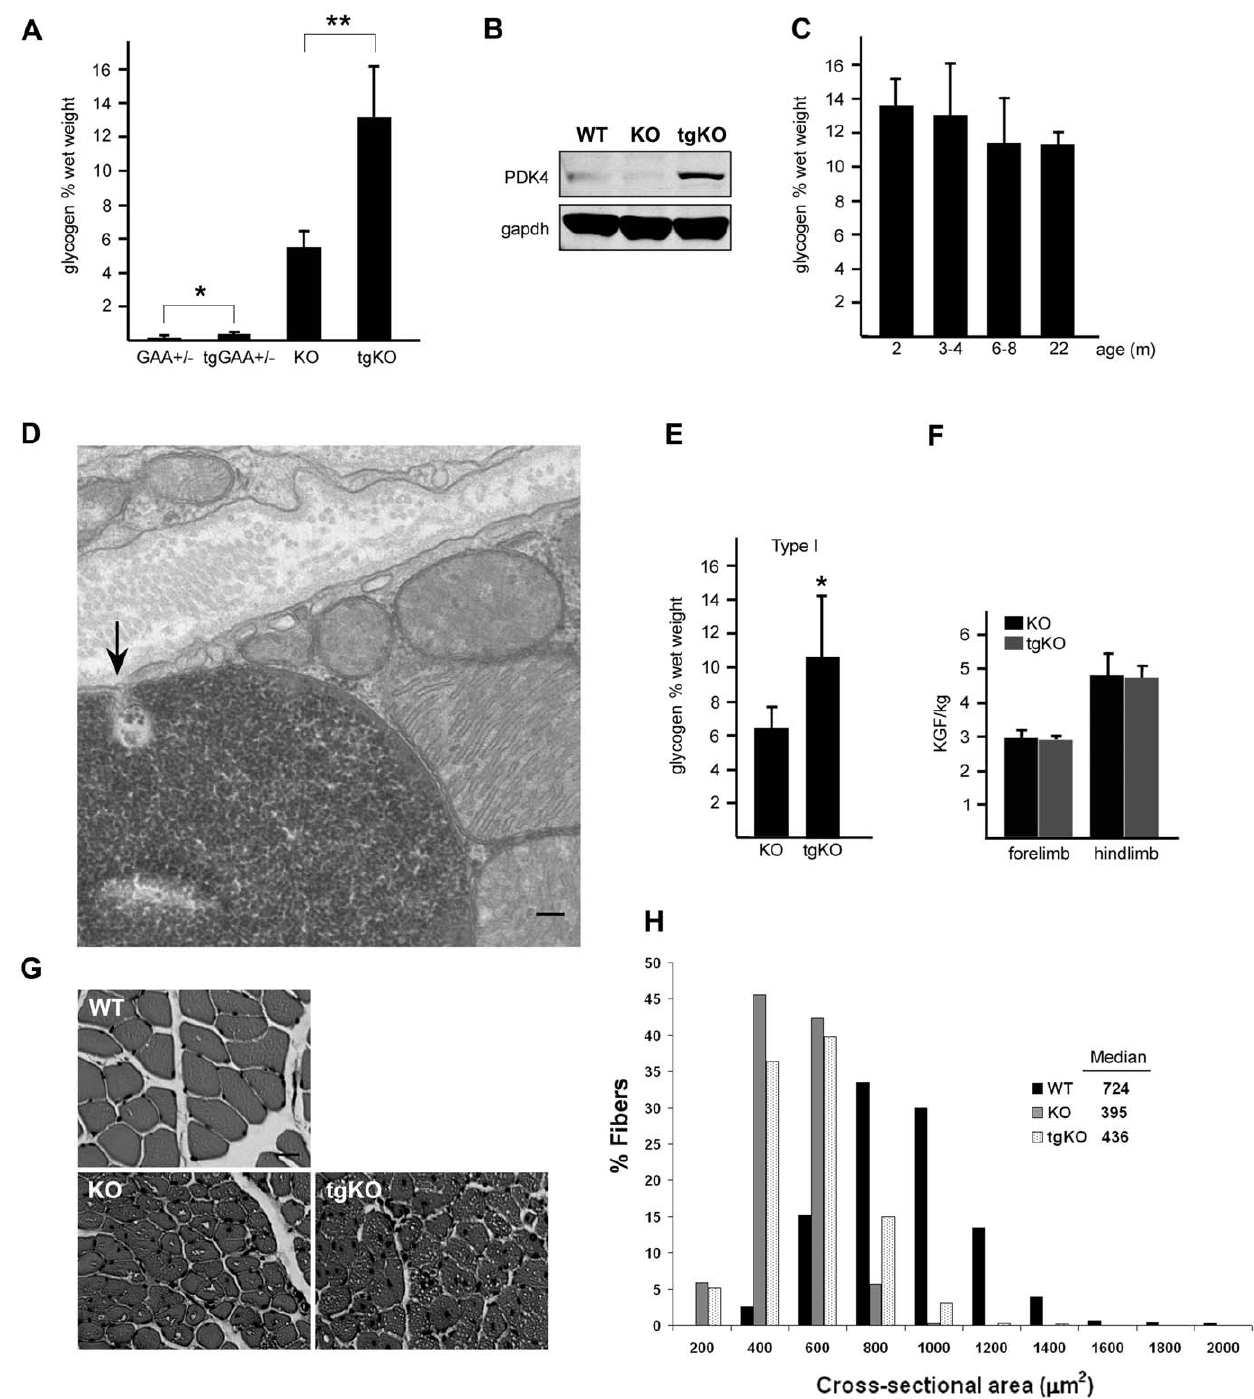
Figure 6. Effect of PGC-1 a on muscle glycogen levels and muscle strength. ( a ). Gastrocnemius (fast) muscles were used for glycogen measurement. Note a striking increase in the amount of glycogen in muscle from tgKO compared to KO; * p , 0.03; ** p , 0.001. ( b ). Western blotting of protein lysates from gastrocnemius (fast) muscles from WT, KO and tgKO mice with PDK4 antibody. ( c ). Glycogen levels in gastrocnemius (fast) muscles from tgKO mice at different ages (n=5 for 2 m; n=11 for 3–4 m; n=6 for 6–8 m; and n=3 for 22 m). ( d ). Electron microscopy of soleus muscle from a tgKO mouse showing glycogen particles (arrow) entering a single membrane lysosome which is already filled with glycogen. Bar: 100 nm. ( e ). An increase in the amount of glycogen is also observed in soleus (type I slow) muscle of the tgKO mice; * p , 0.04. ( f ). Muscle strength of KO and tgKO mice. Each value is the mean 6 sd. from 5 animals. Five consecutive fore- and hindlimb strength measurements were recorded daily for each mouse over a 5-day-period. The maximum values for each day were used for the analysis. The data were normalized to body weight and expressed as KGF/kg. Five month-old male mice were used for the experiments. ( g ) H & E-stained sections of tibialis anterior muscle from 1.5 year-old WT, KO, and tgKO. Both KO and tgKO fibers are atrophic compared to the WT. Bar: 20 m m. ( h ) Histogram showing the distribution of cross-sectional areas of WT, KO, and tgKO muscle fibers.